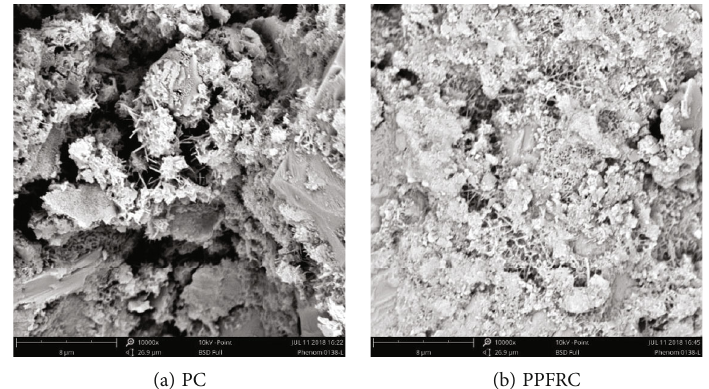
Figure 8: The SEM images of PC and PPFRC mixture at 60 days of curing (magni fi cation